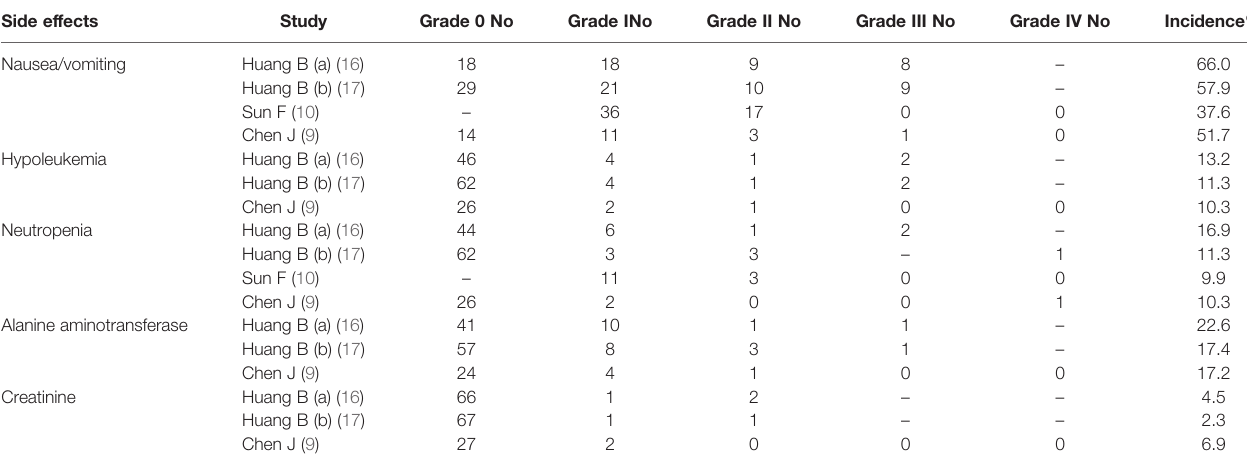
TABLE 4 | Intra-arterial chemotherapy-related side